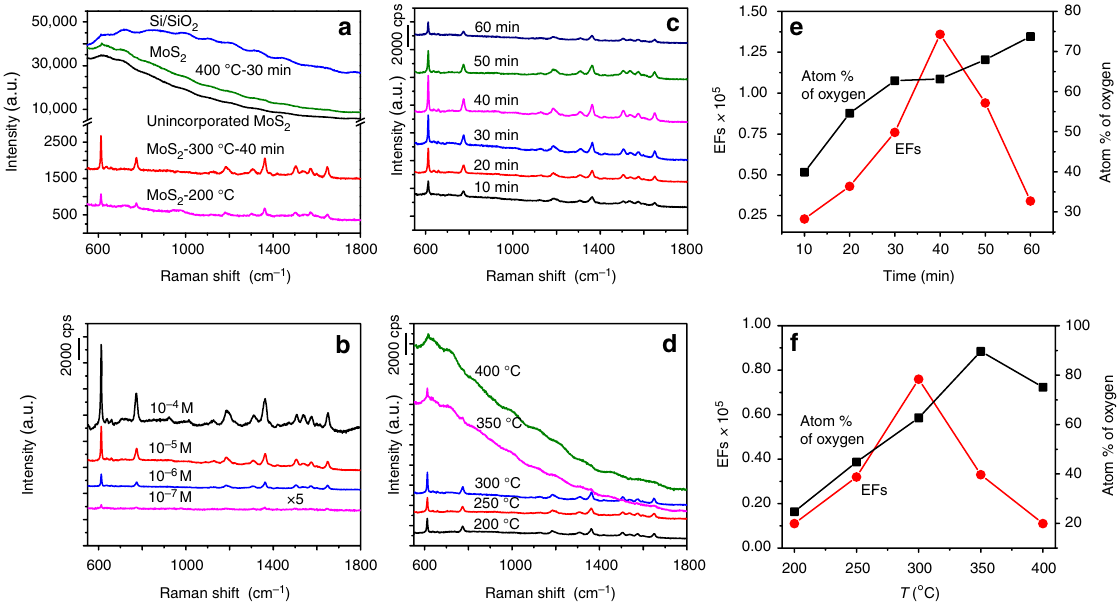
Fig. 4 SERS properties. a Raman pro fi le of R6G (10 − 6 M) on substrates deposited with unincorporated MoS 2 sample, hydrothermally treated oxygen- substituted MoS 2 sample at 200 °C, partially oxidized sample at 300 °C for 40 min, completely oxidized MoO 3 sample, and bare SiO 2 /Si. b Raman spectra collected for oxygen-incorporated MoS 2 sample annealed at 300 °C for 40 min at four different concentrations, 10 − 4 , 10 − 5 , 10 − 6 , and 10 − 7 M, suggesting the detection limit was as low as 10 − 7 M. SERS spectra on the oxygen-incorporated MoS 2 samples with different annealing times ( c ) and temperatures ( d ). e , f The dependence of the SERS enhancement of R6G on the oxygen incorporation concentration for both types of oxygen-incorporated MoS 2